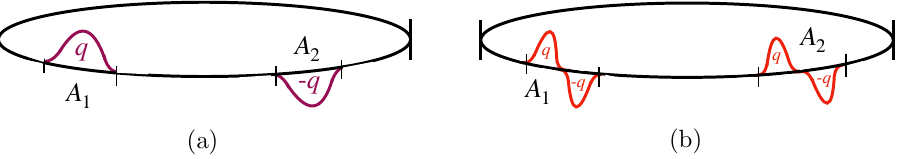
Figure 6. (a) The bi-local intertwiners in A 1 [ A 2 conserve the total charge, R (b) The subalgebra N 1 (cid:26) A 1 does not have any operators that create and annihilate charges inside A 1 (the red excitations). Such an algebra is generated by J ( f ) with functions localized in A 1 .